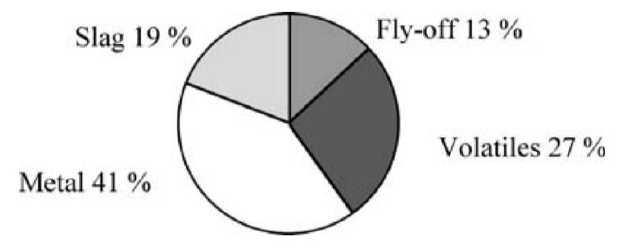
Figure 10. Nature of particulates generated inside an EAF [21].